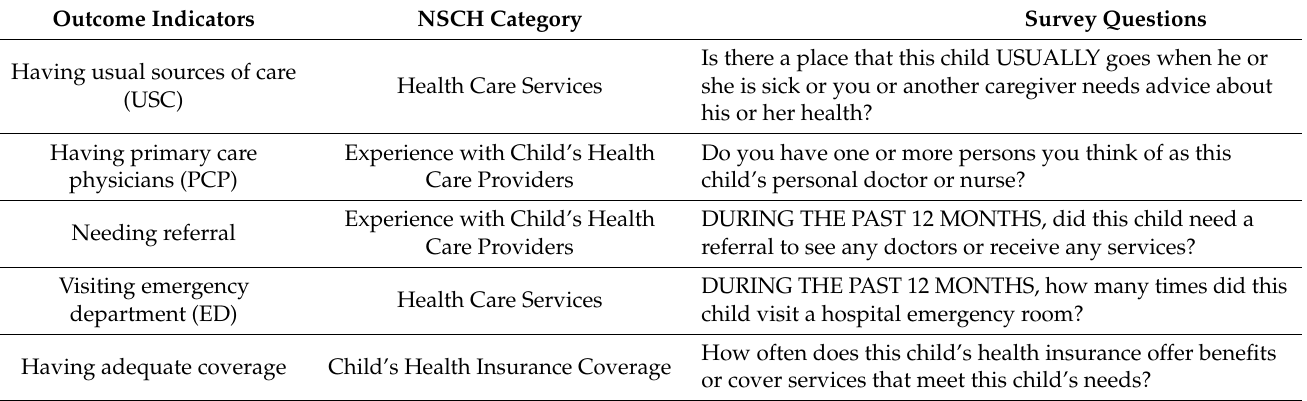
Table A1. Key outcome